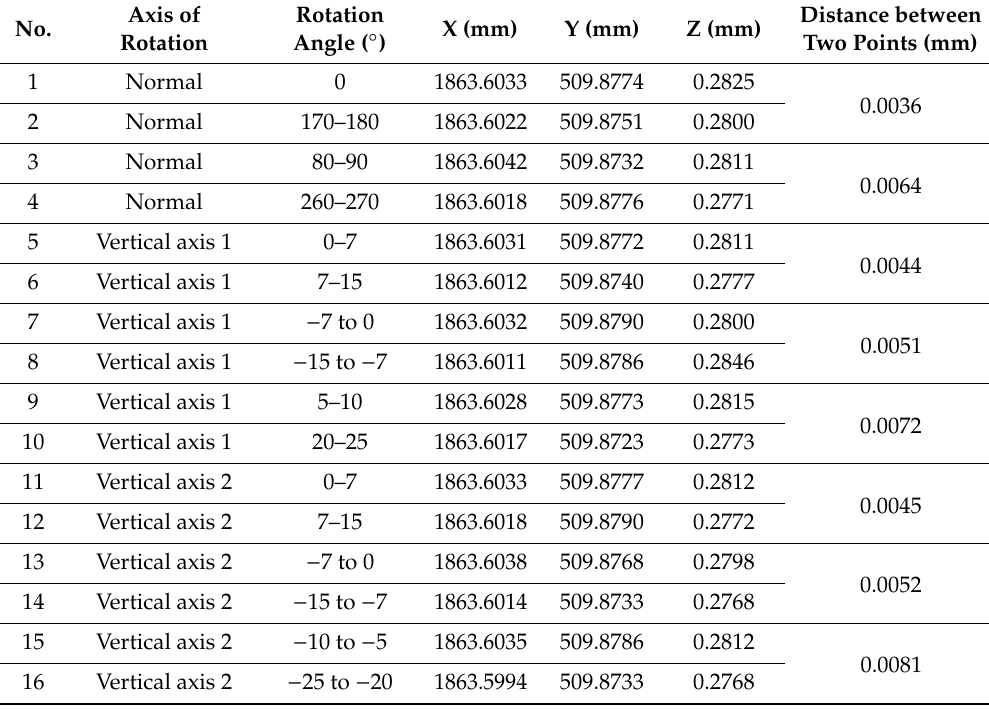
Figure 8. Schematic of the incident angle of the laser ray: ( a ) incident angle of SMR; ( b ) incident angle of laser tracker. Table 1. Errors of the incident angle of the laser ray.